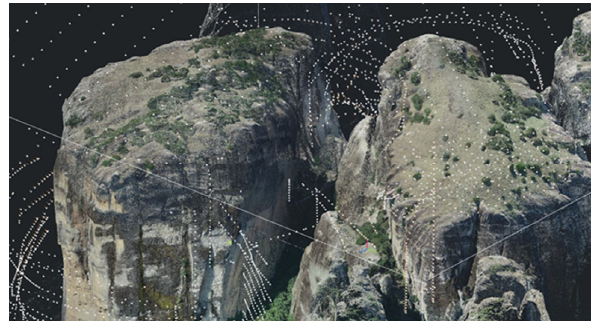
Figure 4. 3D views of the 3D textured models of Modi and